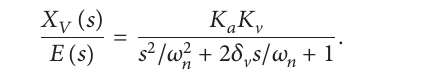
Figure 3: Principle and structure of